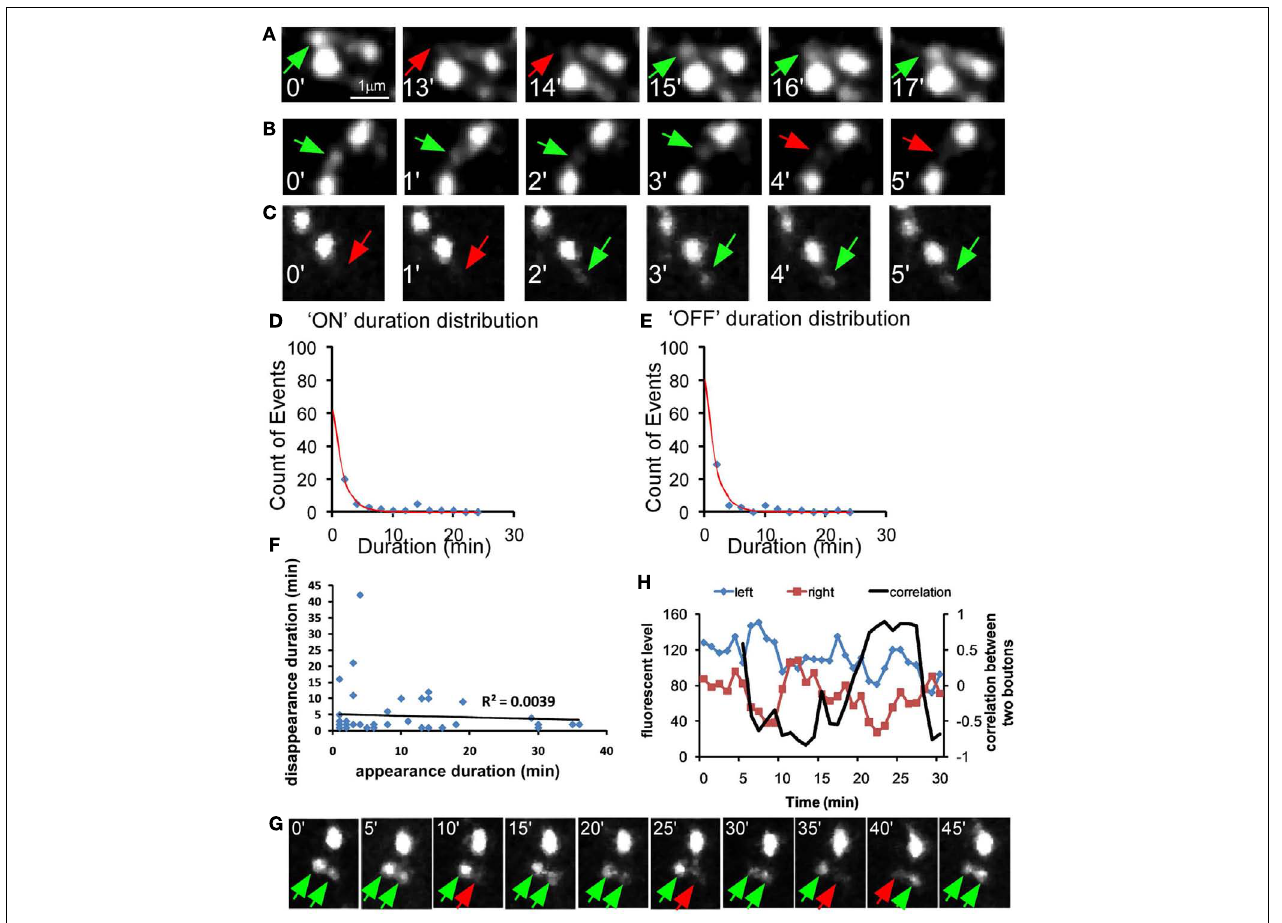
the appearance (ON) and the following disappearance (OFF) duration was plotted for each episode.The linear regression was applied for the data and the R 2 was shown (45 data points from five cells).There was no correlation between the length of ON and OFF duration ( P = 0.68, ANOVA regression analysis). (G) Two neighboring syn-GFP puncta showing reciprocal changes in intensity in tens of minutes. (H) Changes in syn-GFP signal at two neighboring sites in (G) were plotted with time (blue and red curves).The correlation of changes between the two sites was also plotted (black curve; see Materials and Methods).